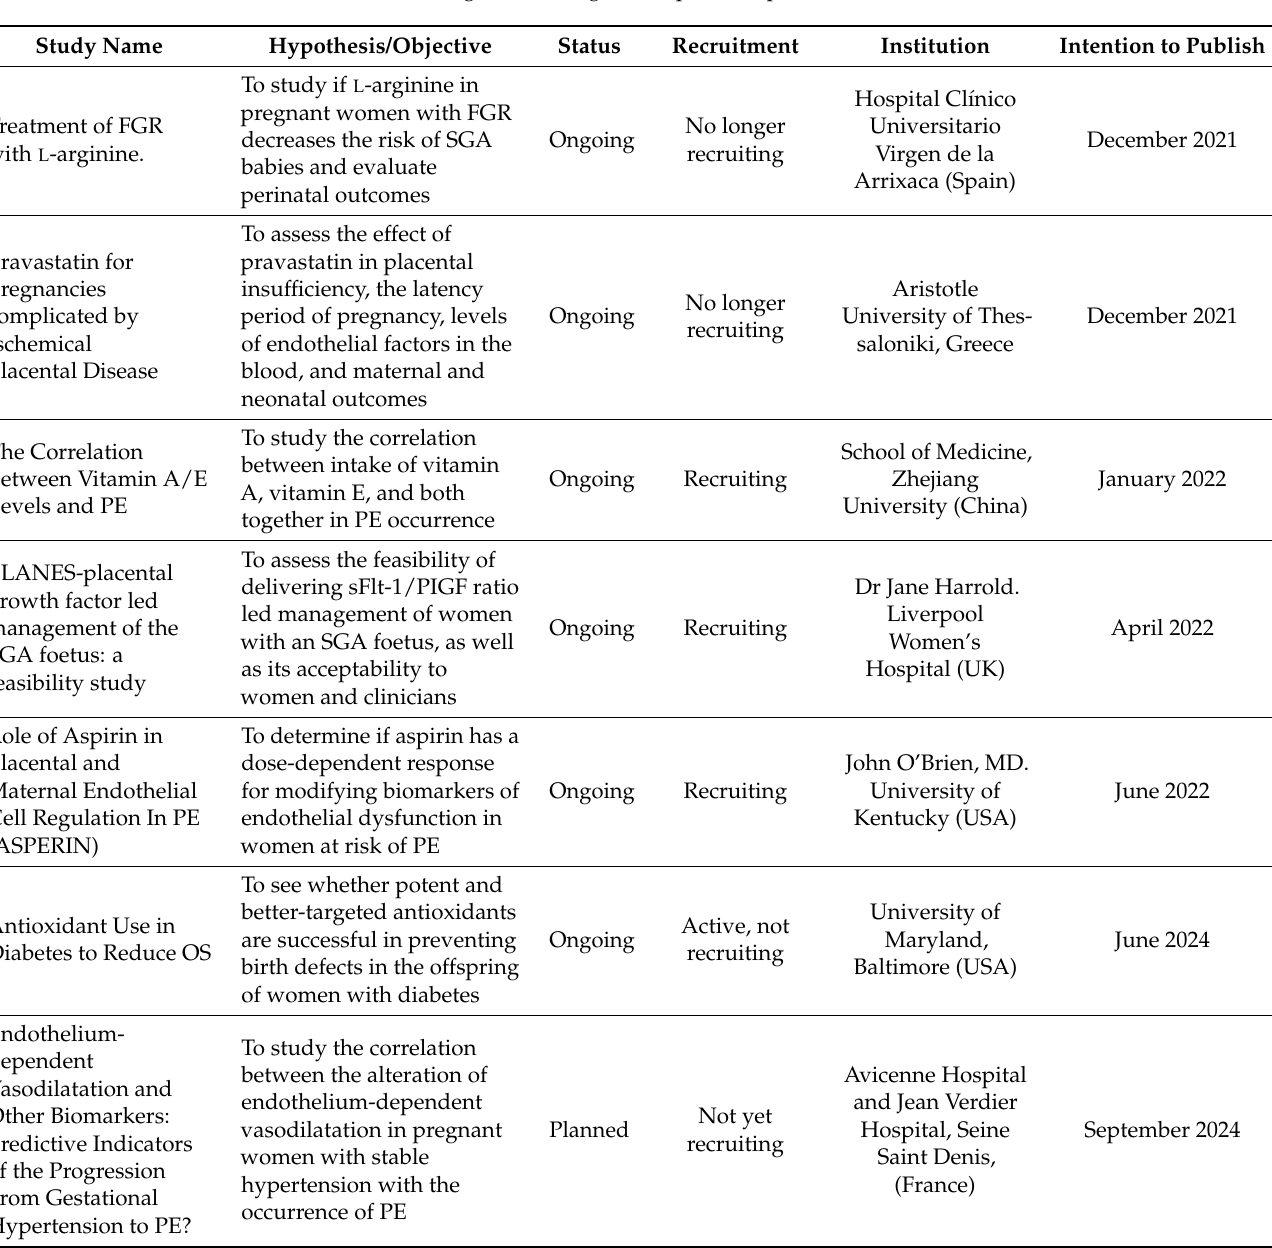
Table 3. Ongoing and planned trials involving antioxidant treatment. FGR = foetal growth